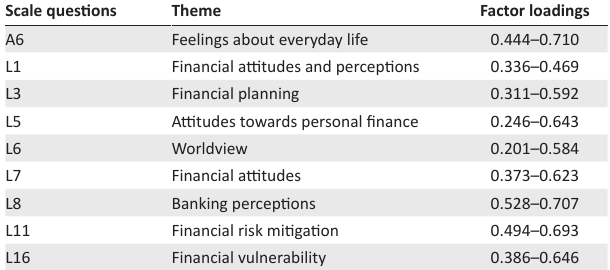
TABLE 4: Validity results of the FinScope